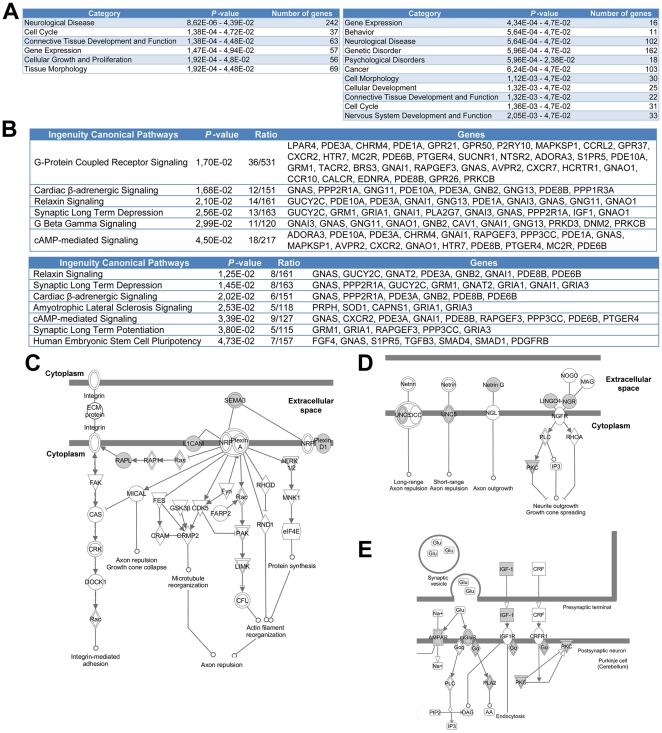
Functional annotations of Arx targets.A) Significantly enriched biological functions obtained from the data in transfected N2a cells (left) or embryonic brain (right) confirm already known functions of Arx in the regulation of gene expression, cellular growth and proliferation and emphasizes its important role in the development of neurological and psychological disorders. The indicated P-value was calculated by Fisher's exact test. B) Significantly enriched canonical pathways associated with Arx targets. The top table indicates enriched genes from transfected N2a cells and the bottom one indicates results from embryonic brain. The indicated P-value was calculated by Fisher's exact test. Ratios correspond to the number of ChIP-positive genes compared to the genes present on the array for each canonical pathway. C) and D) Examples of ChIP-positive genes (indicated in grey) playing a role in the Axonal Guidance canonical pathway (image generated by the IPA program). E) Example of ChIP-positive genes (indicated in grey) playing a role in synaptic transmission (image generated by the IPA program).